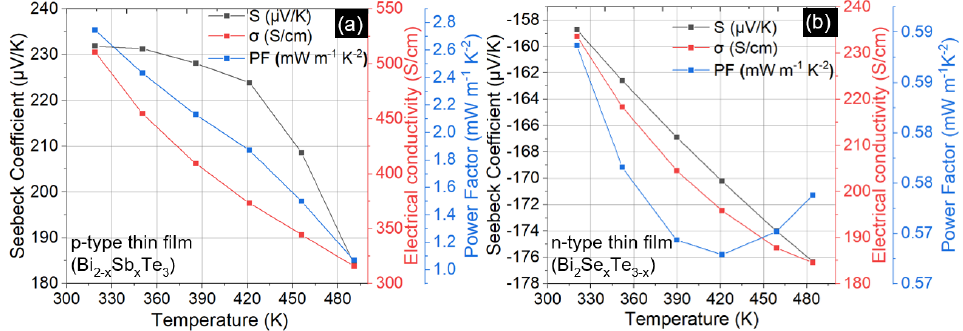
Figure 4. Thermoelectric properties versus temperatures for p-type ( a ) and n-type ( b ) films deposited on glass substrates. Amongst the samples we synthesized, these films had the highest power factor near room temperature.